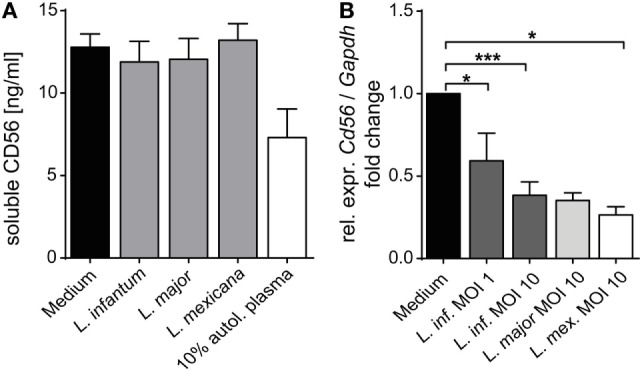
Mechanism of Leishmania-induced reduction of surface CD56 on natural killer (NK) cells. (A) Purified human NKp46+CD3− NK cells were cocultured with Leishmania promastigotes [multiplicity of infection (MOI) 10] for 20 h. The concentration of soluble CD56 in the cell culture supernatants was determined by ELISA. Mean ± SEM of 9/7/6/7/3 donors for the five stimulations. (B) Purified human NKp46+CD3− NK cells were cocultured with Leishmania promastigotes at different parasite/host cell ratios for 20 h. mRNA expression of CD56 was quantified by TaqMan RT-PCR. The expression was normalized against the endogenous control (huGAPDH), and the fold change was calibrated to the respective medium value. Mean ± SEM of 8/3/8/2/5 donors for the five stimulations. *p < 0.05, **p < 0.01, and ***p < 0.001 two-tailed Mann–Whitney U test.